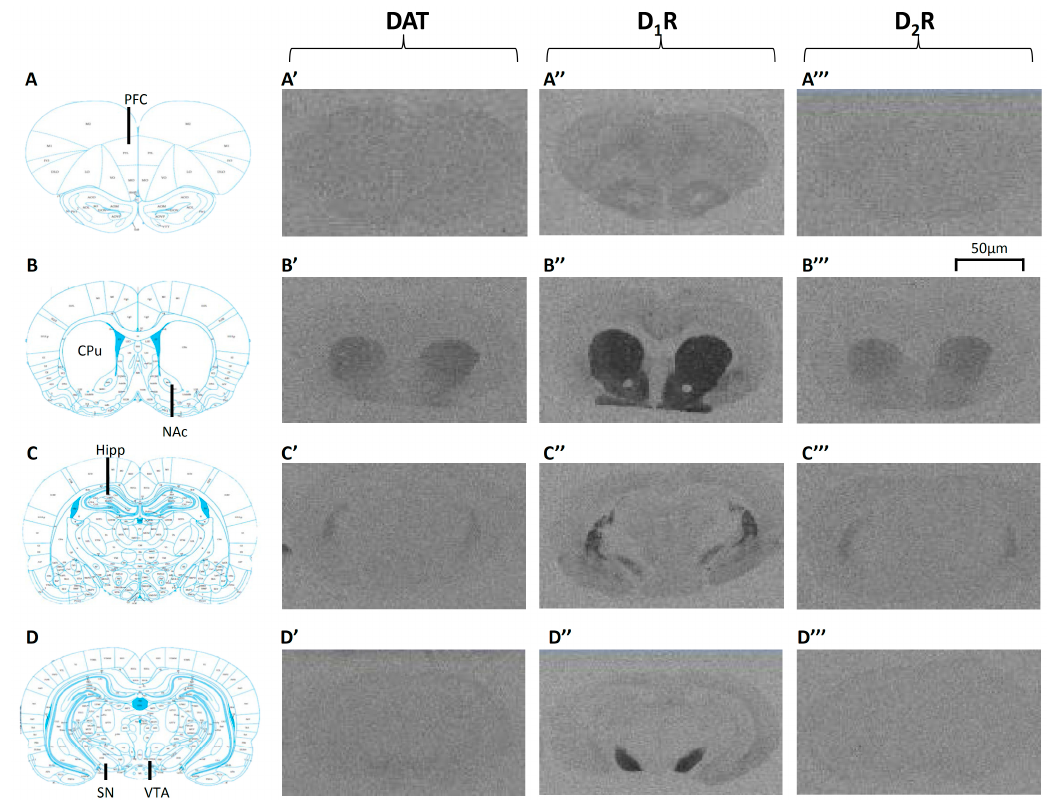
Figure 2. Examples of DAT, D 1 and D 2 receptors binding in the adult rat brain following childhood/adolescent APD treatment. ( A – D ) The schematic diagram adapted from a rat brain atlas [42] showing the level of Bregma for each investigated region (( A ) PFC: 4.68 mm; ( B ) CPu & NAc: 1.08 mm; ( C ) Hippocampus: − 2.76 mm; ( D ) SN & VTA: − 4.92 mm). ( A’ – D’ ) Examples of autoradiograms